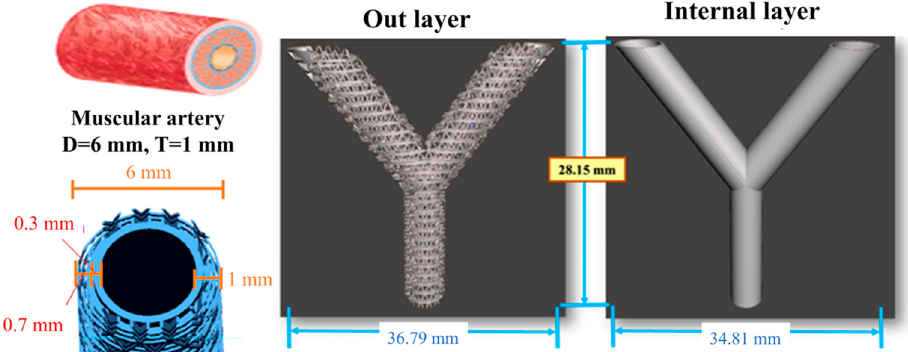
Figure 1. The design of the bi-layer engineering blood vessel scaffold.